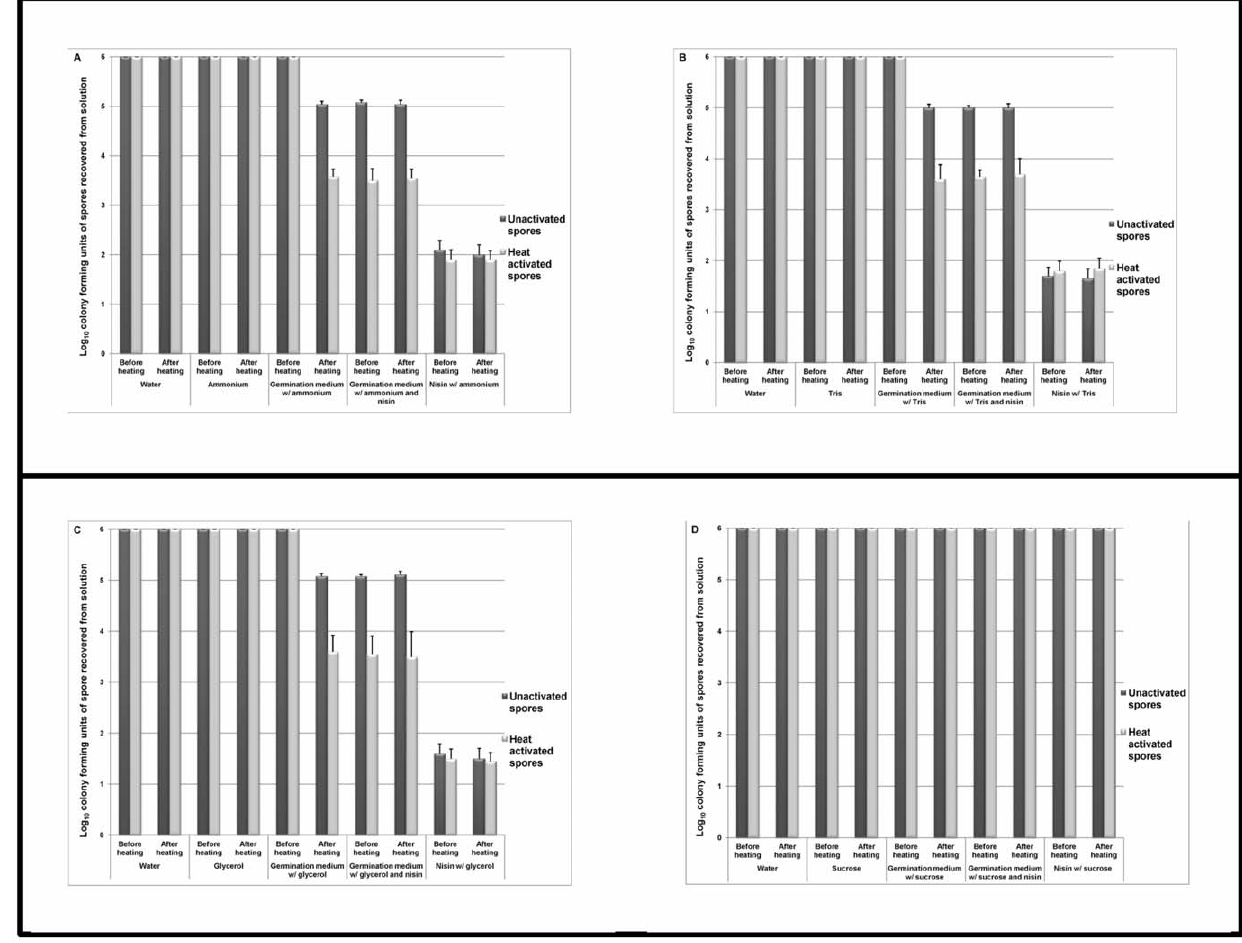
Figure 3. Synergistic effects of nisin and osmotically activated C.difficile spores. The log 10 CFU of unactivated and heat activated spores that were recovered from solutions after 30 minutes of incubation under ambient conditions. Spore suspension were either plated before heating or after heating at 80 u C for 5 minutes (kills germinated but not dormant spores). Figure 3A–C shows solutions containing solutes that readily permeate plasma membranes (ammonium hydroxide, TRIS HCl, and glycerol). Figure 3D shows solutions containing sucrose which does not permeate plasma membranes. Spores were confirmed as dormant or germinated by phase contrast microscopy and DPA release. The means of the data from experiments conducted in triplicate are presented. Error bars indicate standard error.